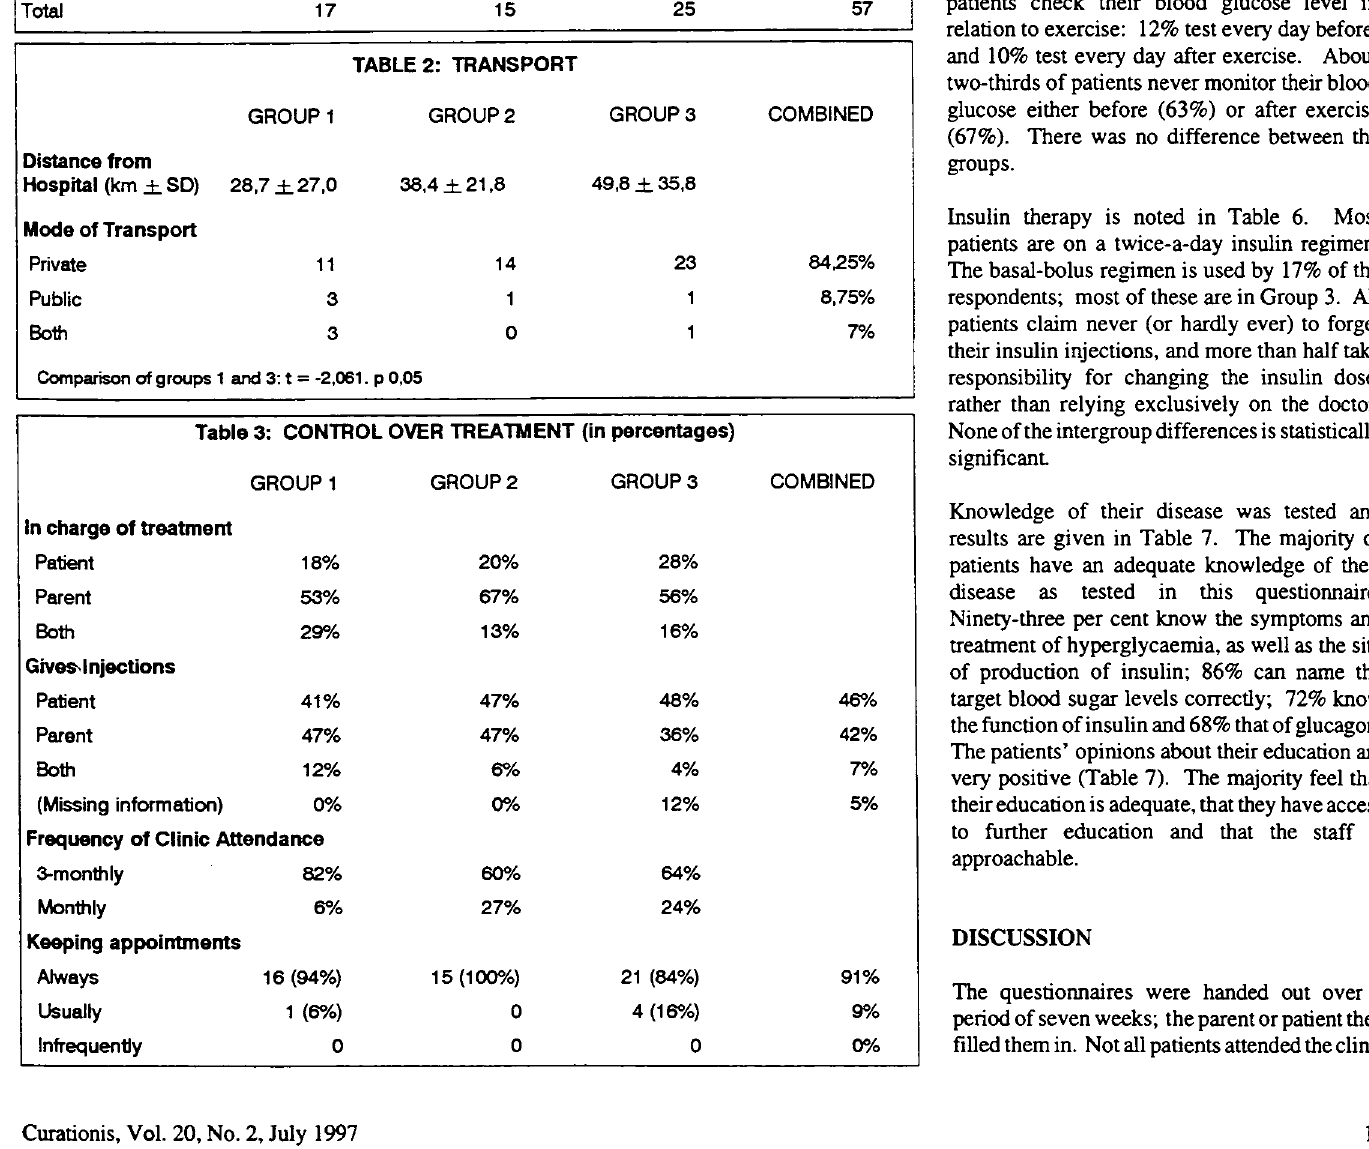
Table 3: CONTROL OVER TREATMENT (in